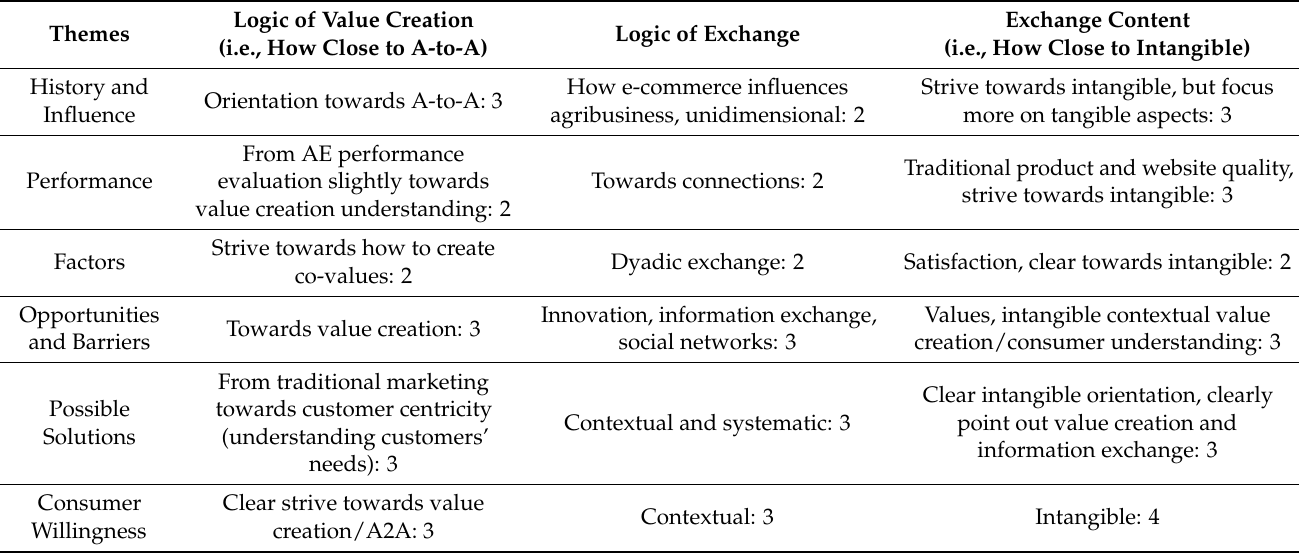
Table 2. A comparative analysis of S-D logic concepts and literature.